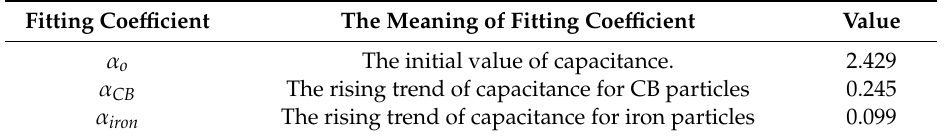
Table 1. The fitting coe ffi